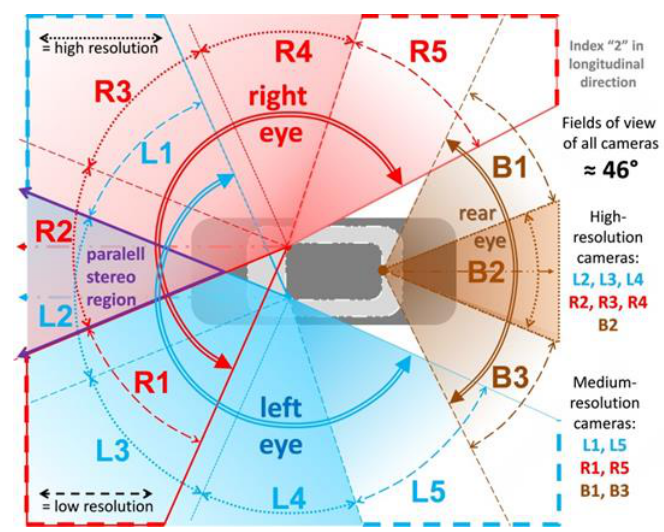
Figure 14. Car with a pair of body-fix eyes in the front at the left (Li) and right side (Ri) of the roof, and a set of three cameras looking to the rear (Bi).